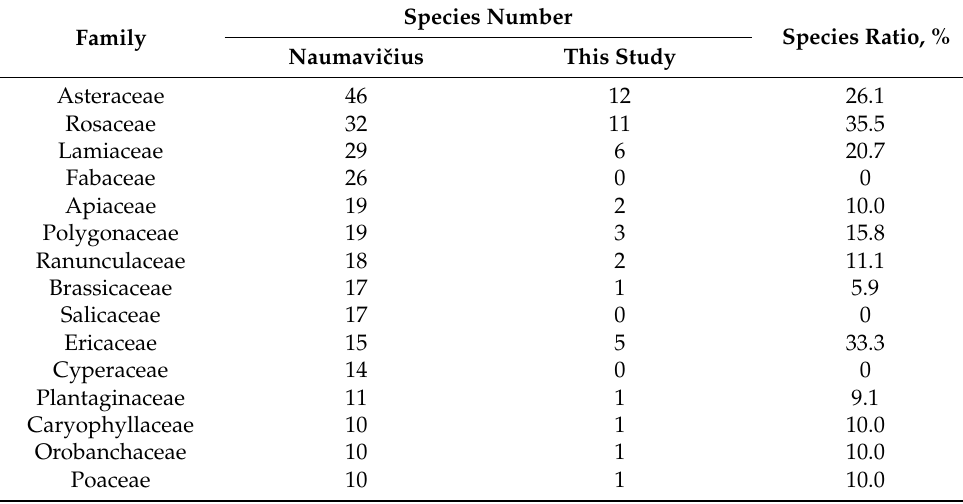
Table 1. The number of species of Lithuanian native medicinal plants in the most abundant families according to Naumaviˇcius [7] and their number and ratio recorded in this study.